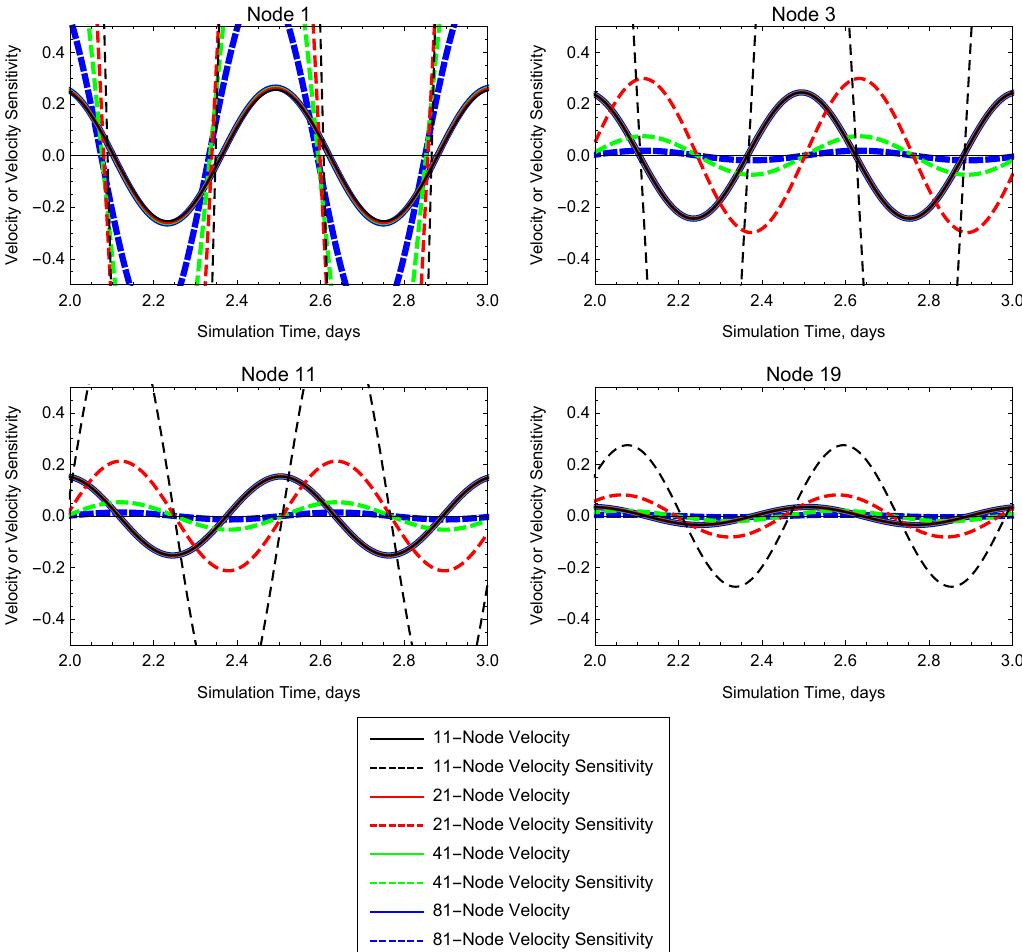
Figure 2. Velocity (m/s) and velocity sensitivity to G (m) for different simulations on the linear sloping domain, with each simulation using a different resolution grid (11-node, black; 21-node, red; 41-node, green; and 81-node, blue). The solid lines depict the velocity results, while the dashed lines show the temporal evolution of the sensitivity of the velocity to G . The node number listed in the title for each panel is the node number in the 21-node grid associated with a given